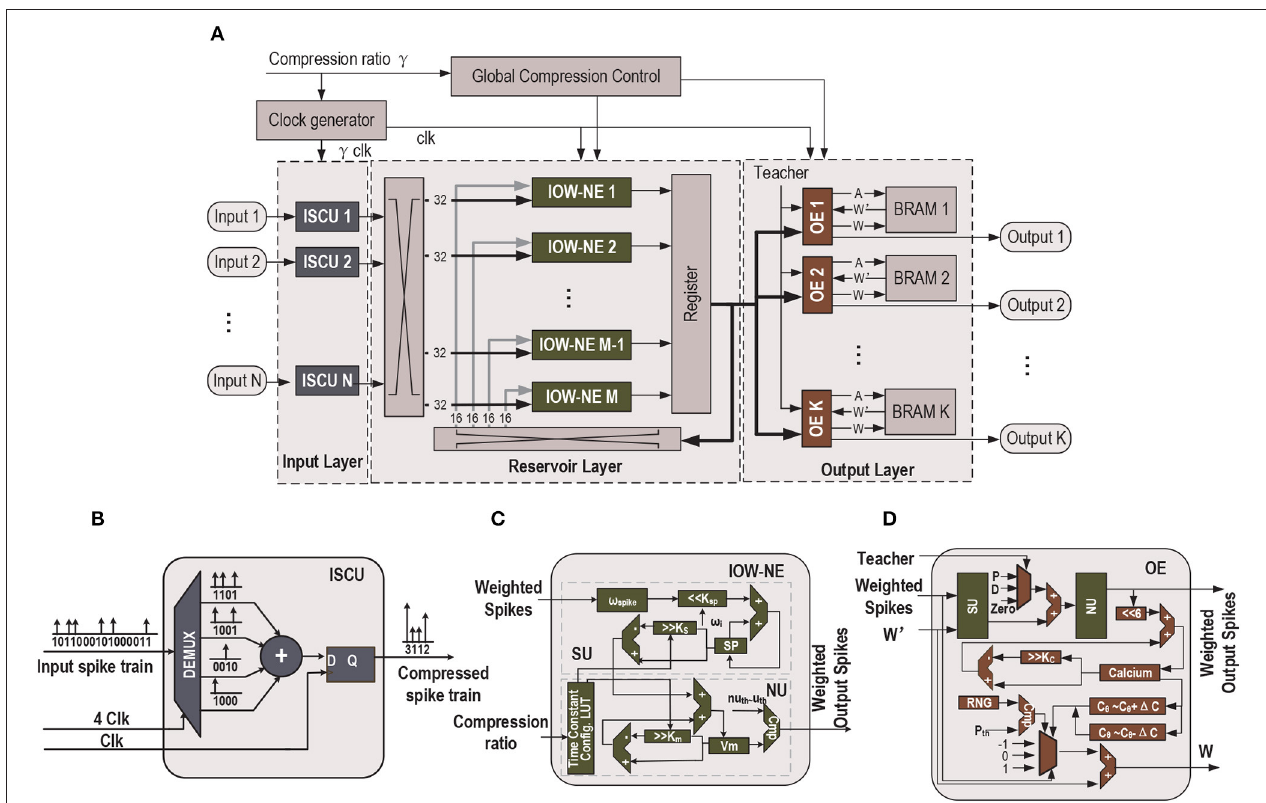
FIGURE 7 | (A) Top-level block diagram of the proposed time-compressed liquid state machine (LSM) SNN accelerator with programmable compression ratio (PTC-SNN), (B) ISCU with 4:1 time compression, (C) LIF IOW neuron: SU - synaptic unit, NU - neural unit, and (D) OE: P - Potentiation, D - Depression ( Wang et al.,